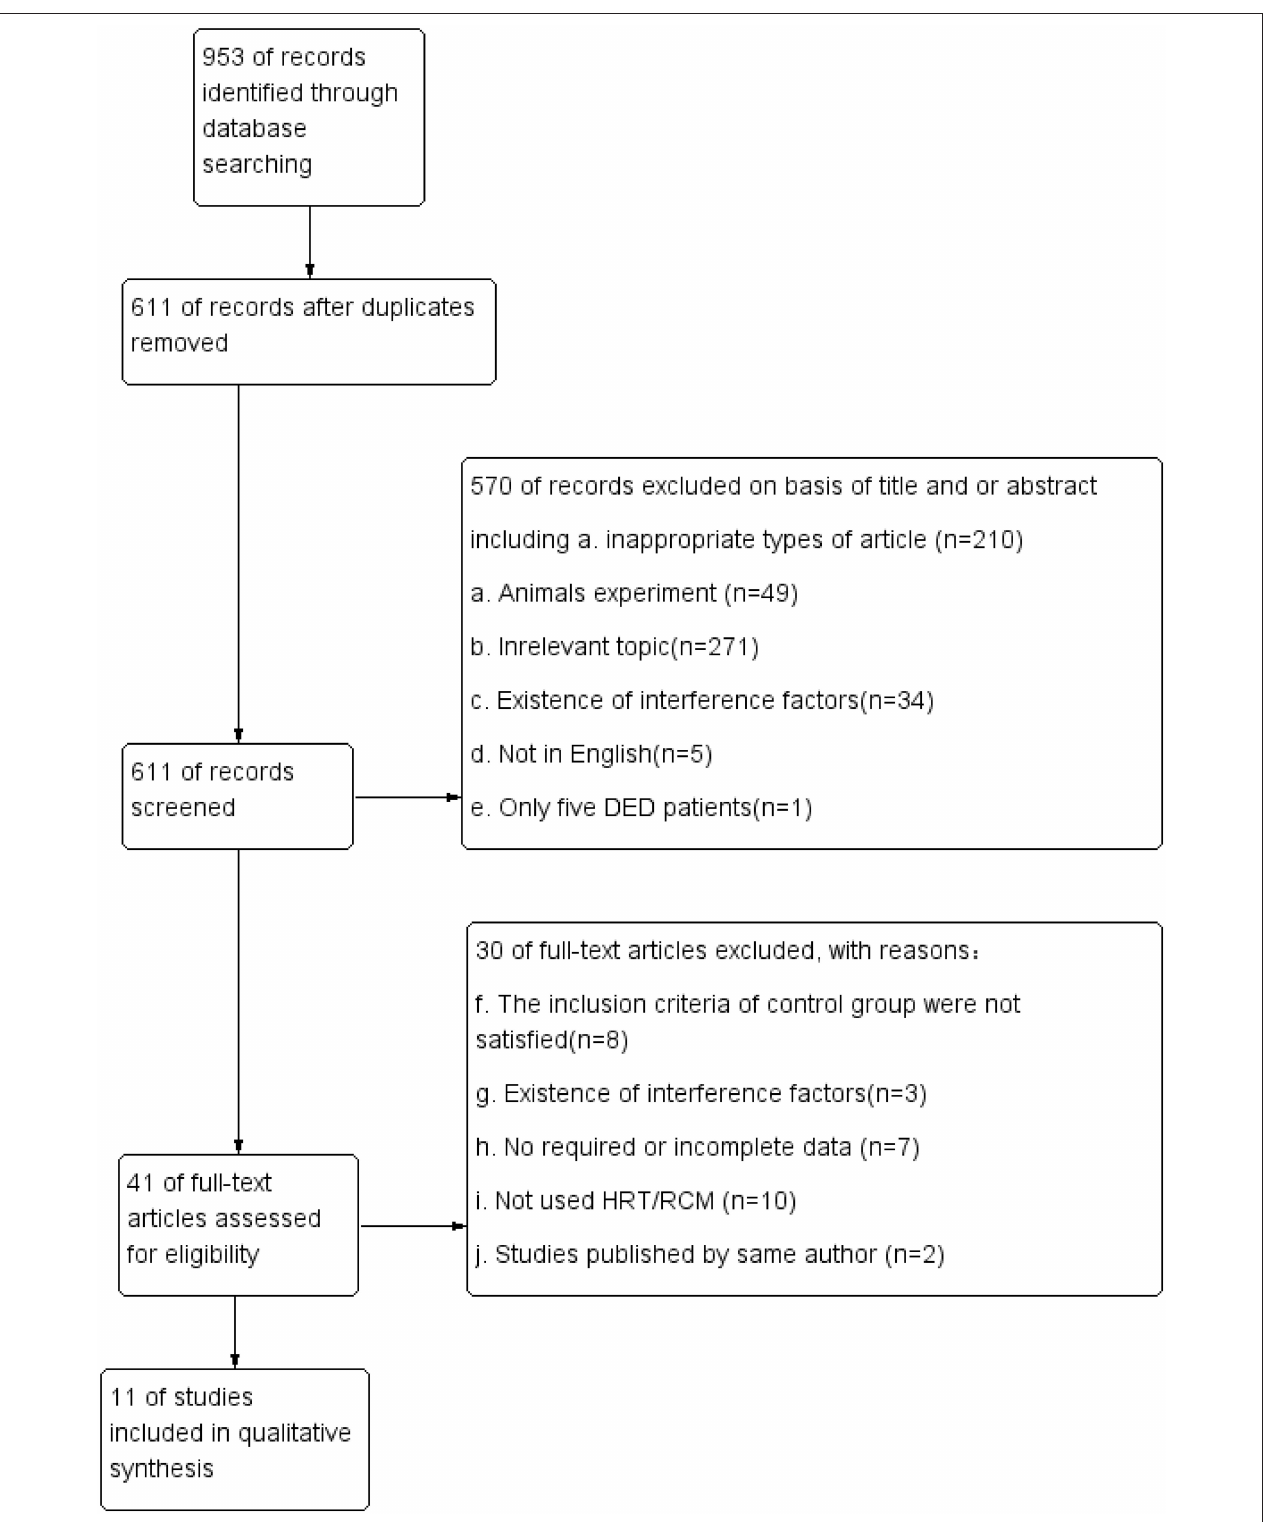
FIGURE 1 | Study flow diagram of article